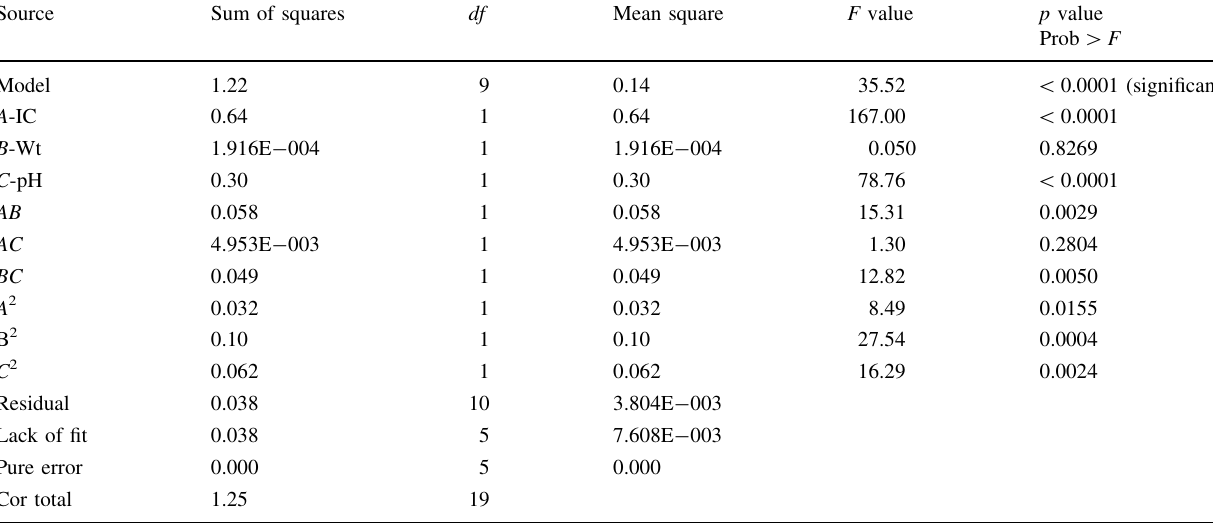
Table 10 Analysis of variance table for fluoride removal